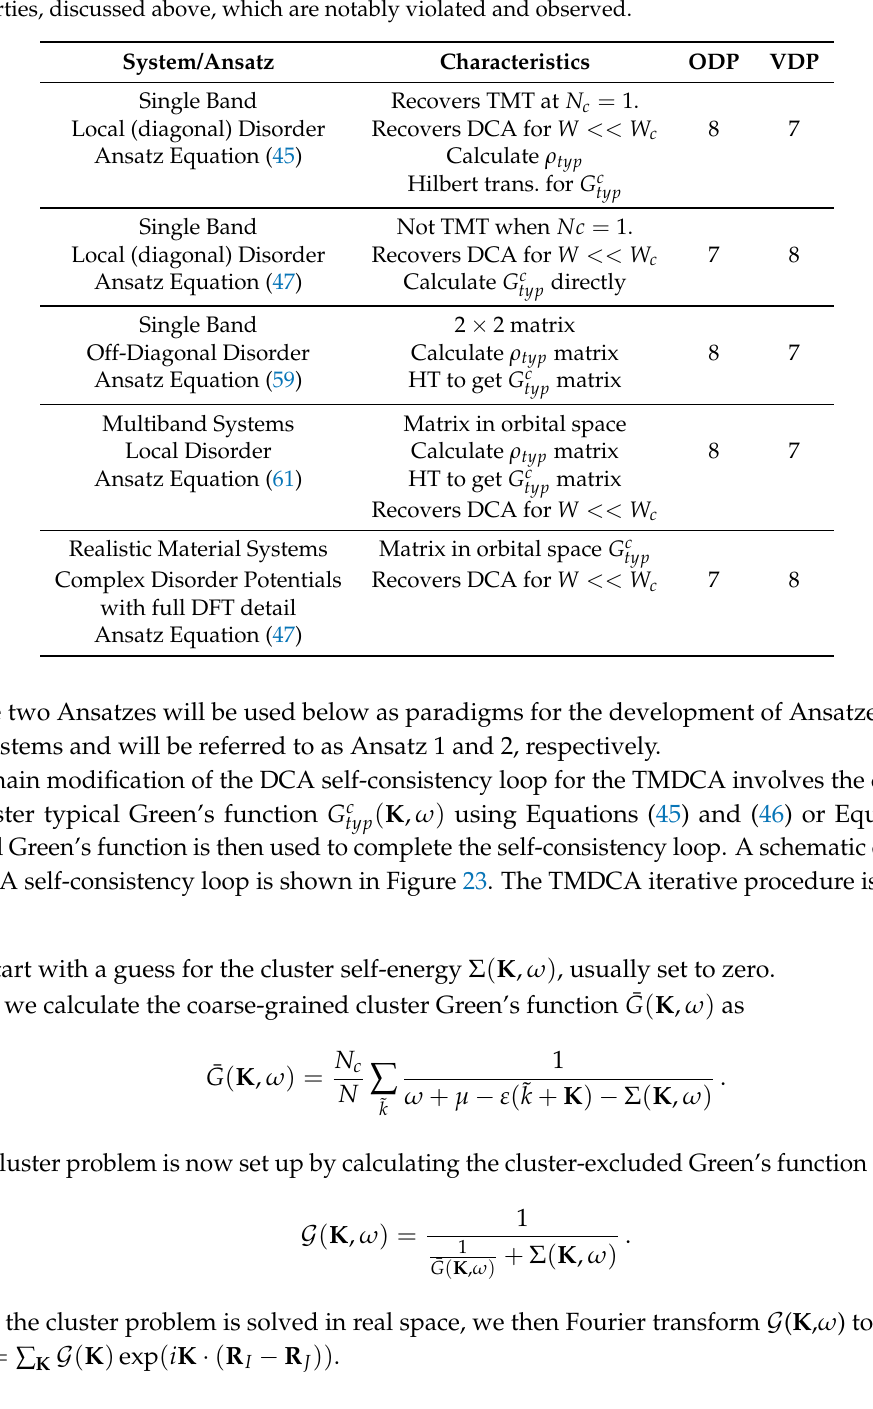
Table 1. A progression of TMDCA algorithms, with each one able to incorporate greater chemical detail as we go down the list. The first column lists systems that may be studied together with the label of the defining Ansatz. The second column lists some additional characteristics including a brief discussion of the desirable properties. The columns labeled VDP and ODP identify the desirable properties, discussed above, which are notably violated and